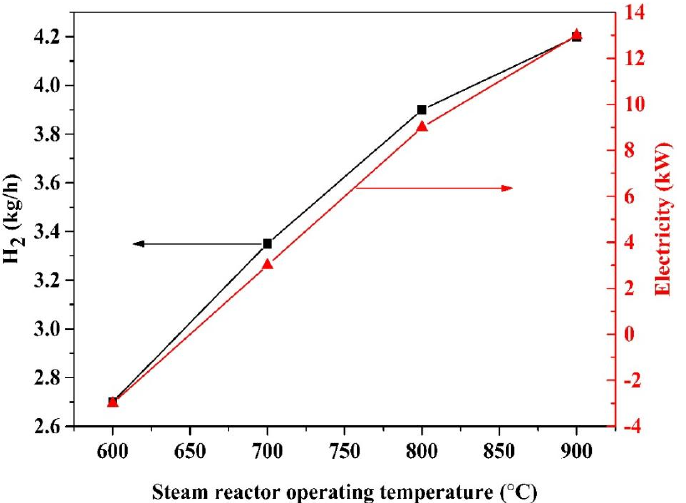
Figure 5. In fl uence of the steam reactor operating temperature on hydrogen and electricity produc- Figure 5. Influence of the steam reactor operating temperature on hydrogen and electricity tion, the temperatures of the pyrolysis reactor, fuel reactor and air reactor are 500 °C, 900 °C and 980 °C.